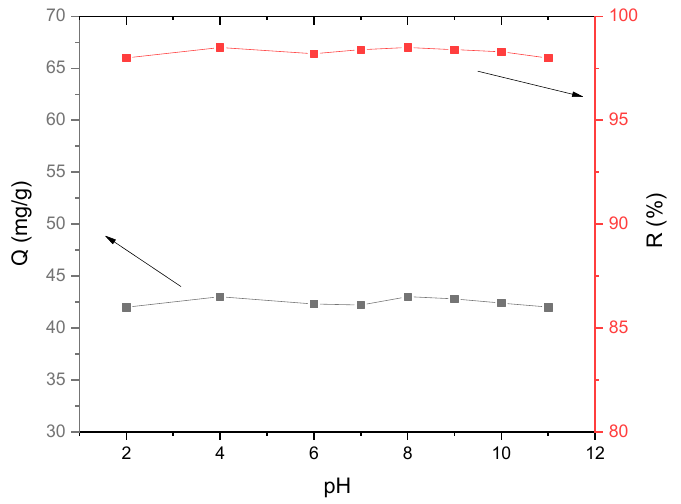
Figure 3. Effect of pH on the MG adsorption using AP from aqueous solution (m = 0.1 mg, Ci = 5 × 10 − 5 M, T = 303K).